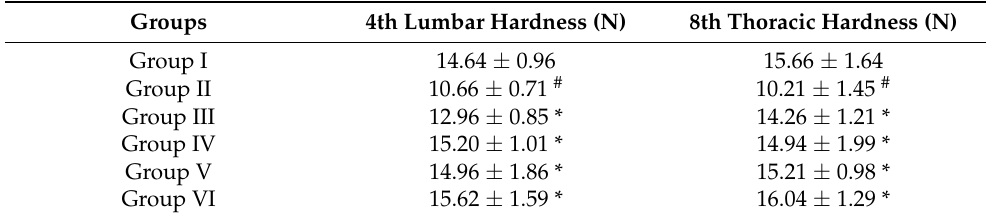
Table 5. Effect of therapeutic interventions on 4th lumbar vertebrae hardness and 8th thoracic vertebrae